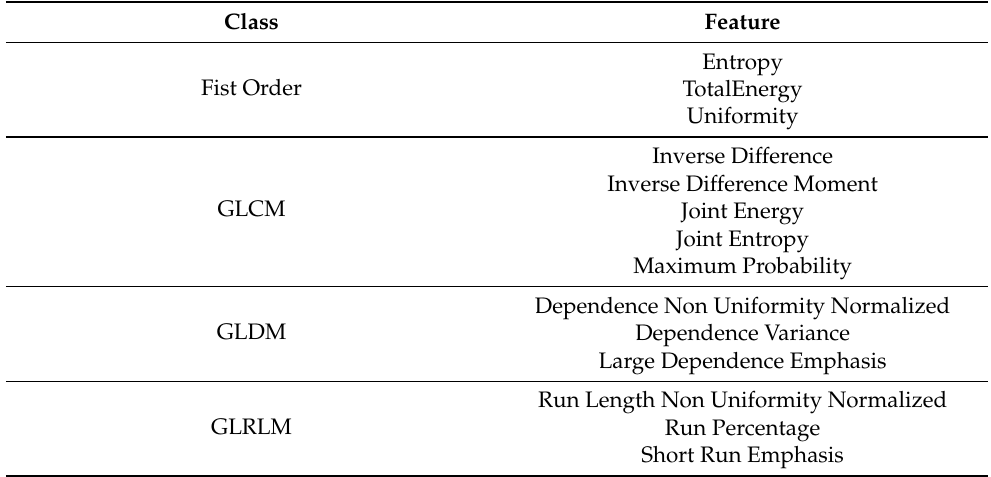
Table 5. Features from the study [31].